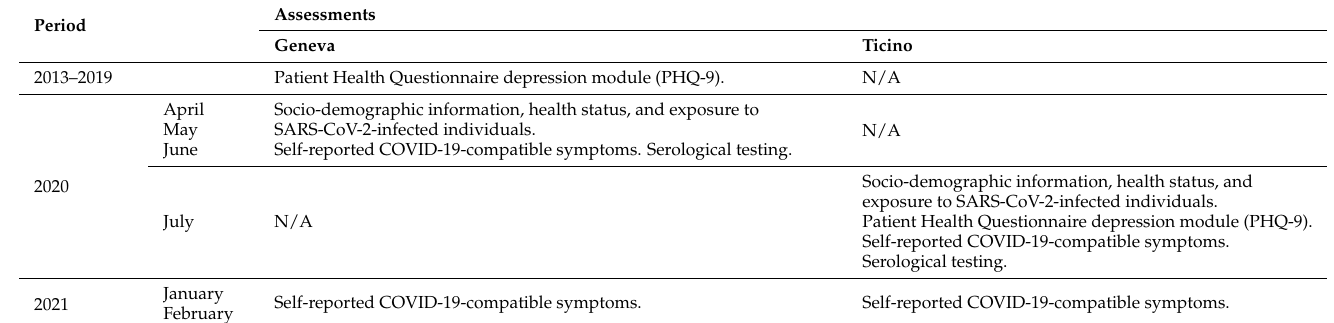
Table A1. Longitudinal data collection design across study sites and assessments.